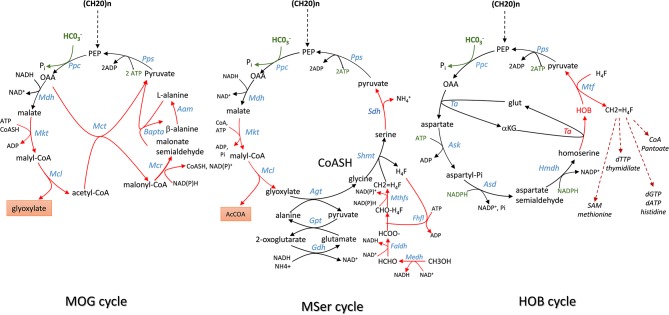
Scheme of Malonyl-coA-Oxaloacetate- Glyoxylate (MOG), Modified Serine (MSer) and 4-hydroxy-2-oxo-butyrate (HOB) cycling pathway employing the efficient PEP carboxylase to capture Co2 into either product or biomass. Enzymes abbreviation are: Ppc, PEP carboxylase; Mdh, malate dehydrogenase; Mtk, malate thiokinase; Mcl, malyl -CoA lyase; Mct, malonyl-CoA acetyl transferase; Mcr, malonyl CoA reductase; Bapta, β-alanine: pyruvate transaminase; Aam, alanine 2,3 aminomutase; Pps, PEP synthase; Ta, transaminase; Ask, aspartate kinase; Asd, aspartyl-Pi semialdehyde dehydrogenase; HmdH, homoserine dehydrogenase; Hmtf, hydroxymethyl transferase.